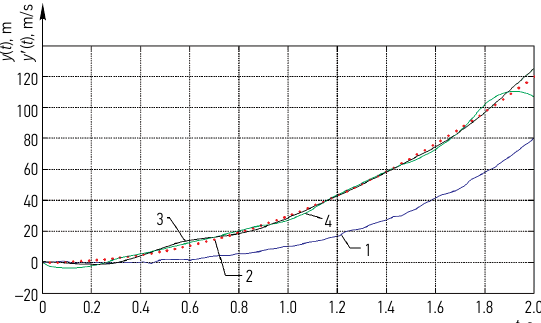
Fig. 1. The derivatives (car speeds), numerically calculated by the classical and offered methods from the input signal ( )  σ = with the standard deviation   0.5 n t of input Gaussian